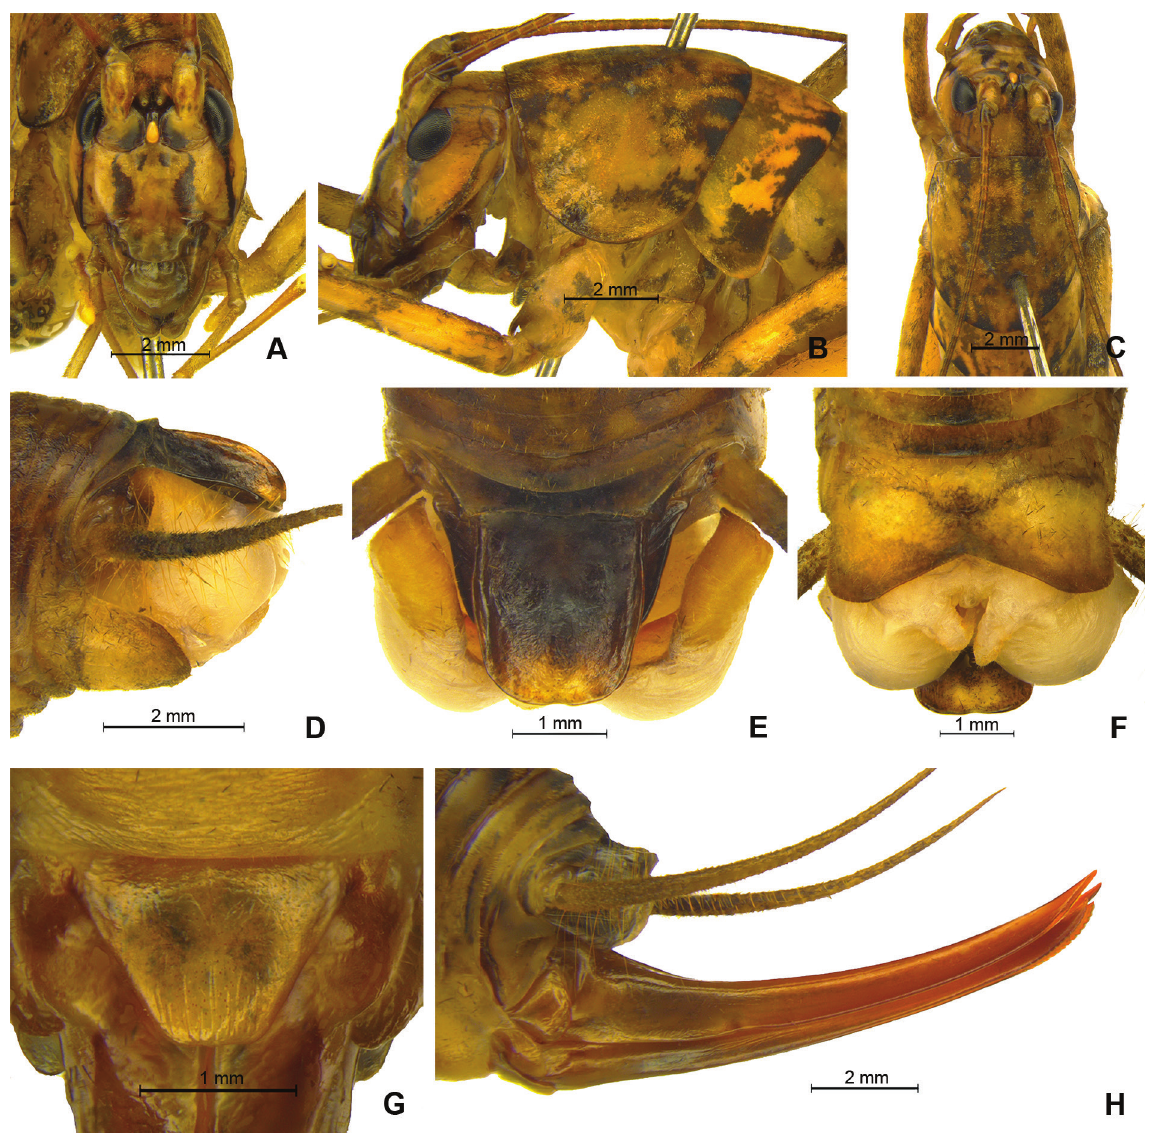
Fig. 3. Megatachycines elongatus (Qin, Liu & Li, 2017) comb. nov. A–F . ♂. A–C . Head and